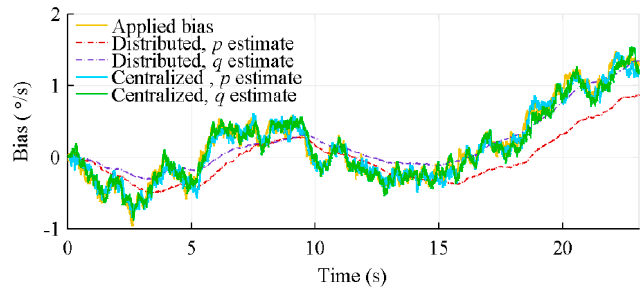
Figure 15. Bias estimation of gyroscopes measuring 𝑝 and 𝑞 , for 64 IMUs, with algorithms considering sensors location.